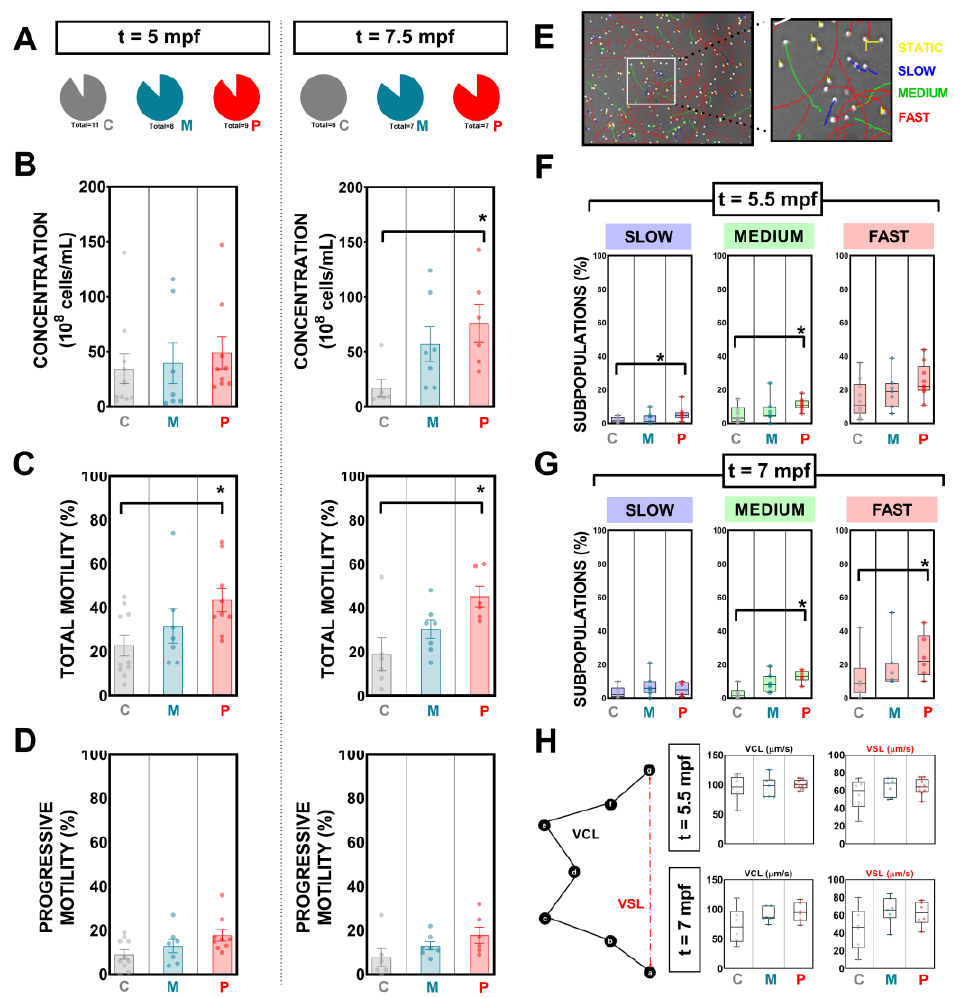
Figure 4. Mixture supplementation effects on zebrafish sperm kinematics after a long exposure of ingestion. ( A ) Percentage of spermiating males at the two studied times. ( B ) Concentration, ( C ) total motility, and ( D ) progressive motility at 5 and 7.5 mpf reported for each experimental group. ( E ) Example of a CASA field rendering static, slow, medium, and fast subpopulations. ( F ) Sperm subpopulations within the motile population according to speed parameters at 5 and 7.5 mpf ( G ) for each group. ( H ) Diagram describing curvilinear and straight velocities and box graphs (whiskers show min. to max.) at different key temporal points showing results from each experimental group. Data are presented as means ± s.e.m. “C”, “M”, and “P” refer to the experimental groups: control diet-fed, maltodextrin-fed, and probiotics-fed, respectively. Asterisks show statistically significant differences: * ( p < 0.0500).